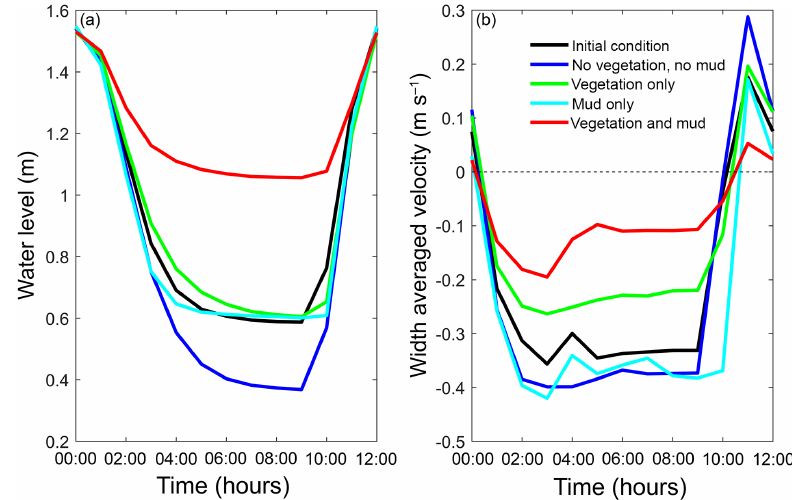
Figure 11. The final tidal cycle in the central estuary at 6km from the mouth, showing the strongest reduction for the scenario with combined mud and vegetation. (a) Tidal water level. (b) Width-averaged flow velocities over the cycle.